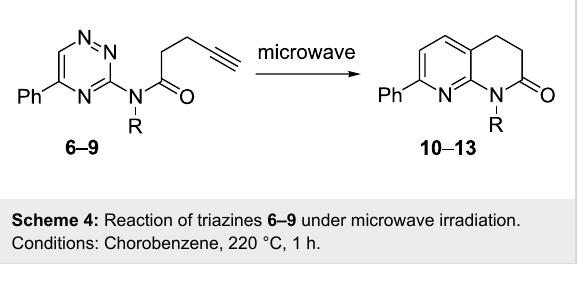
Scheme 4: Reaction of triazines 6–9 under microwave irradiation. Conditions: Chorobenzene, 220 °C, 1 h.